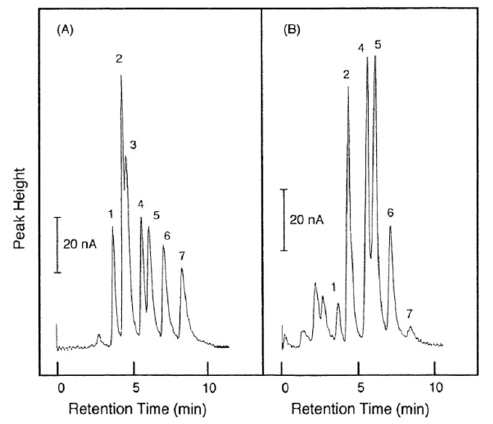
Figure 5. Fatty acid chromatograms of ( A ) sample with standards and ( B ) human serum. Peaks: 1, arachidonic acid; 2, palmitoleic and linoleic acids; 3, myristic acid; 4, oleic acid; 5, palmitic acid; 6, margaric acid (IS); 7, stearic acid. [28]—Reproduced with the permission of Elsevier.